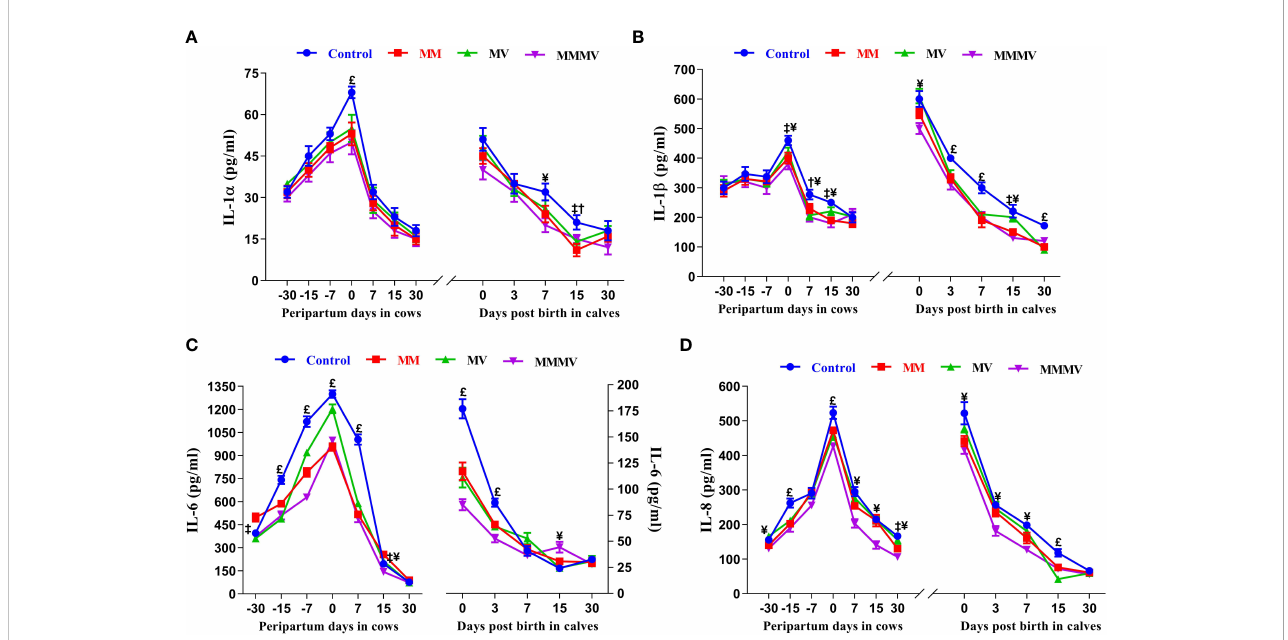
FIGURE 7 The blood plasma concentration of pro-in fl ammatory cytokines (pg/ml) including IL-1 a (A) , IL-1 b (B) , IL-6 (C) , and IL-8 (D) in control and treatment groups of crossbred cattle and their calves. Control: received basal diet only, MM: basal diet + injectable multimineral, MV: basal diet + injectable multivitamins, MMMV: basal diet + combination of injectable multimineral and multivitamins. The mean values with different superscript symbols represent signi fi cant differences with the control group at different days of peripartum in cows and post birth in calves; ‡ Control Vs MM, † Control Vs MV, ¥ Control Vs MMMV. £ Control Vs MM, MV and MMMV.